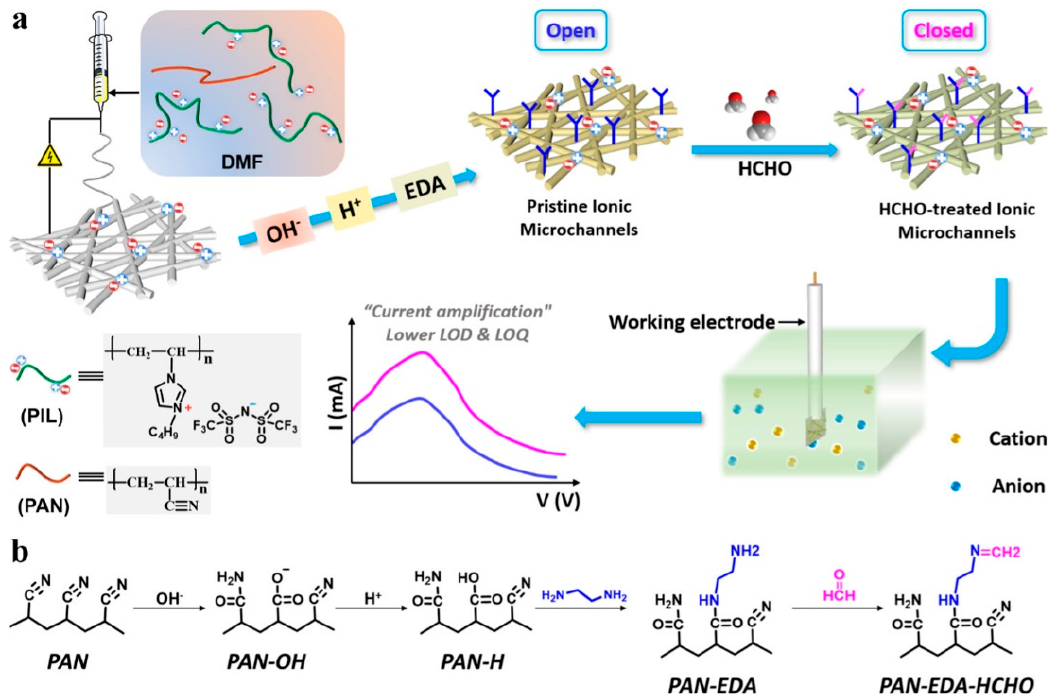
Figure 5. ( a ) Schematic illustration of ultrasensitive recognition of formaldehyde and stronger ionic current signals output of the designed ionic microchannels: the poly (ionic liquid) backbone inside of the ionic microchannels can promote a higher ionic current output. Moreover, when formaldehyde reacted with pristine ionic microchannels (“open state”), the surface could switch from “open” to “closed” (i.e., formaldehyde-treated ionic microchannels), and then the current signal outputs of formaldehyde-treated ionic microchannels were stronger. Therefore, it could be used to realize a lower LOD and lower limit of the quantity (LOQ) for formaldehyde determination. ( b ) The overall chemical reactions of the designed ionic microchannels with formaldehyde [100]. (Copyright (2020) American Chemical Society).